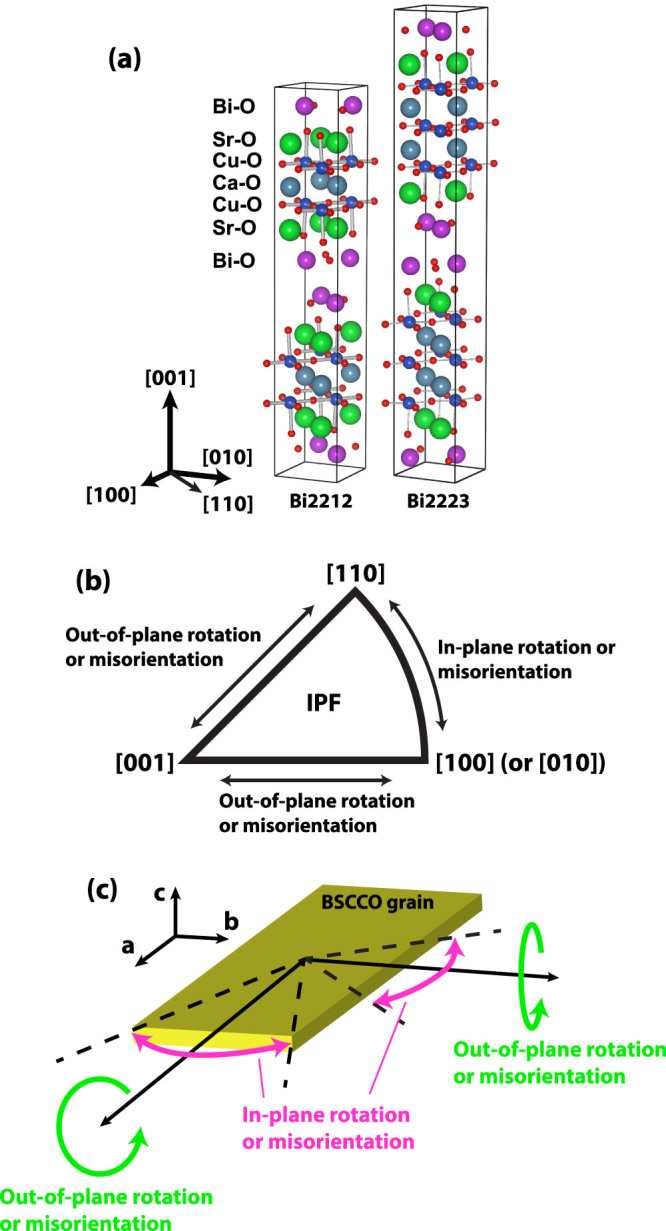
(a) Crystal structures of Bi2212 and Bi2223 and definition of unit axes. (b) Location of grain misorientations on the inverse pole figure (IPF). (c) Schematic illustration of in-plane and out-of-plane rotations of the BSCCO grains. The broad flat surface of a BSCCO grain is always parallel to its ab-plane. Note that the axes of out-of-plane rotations can take any directions containing its ab-plane.